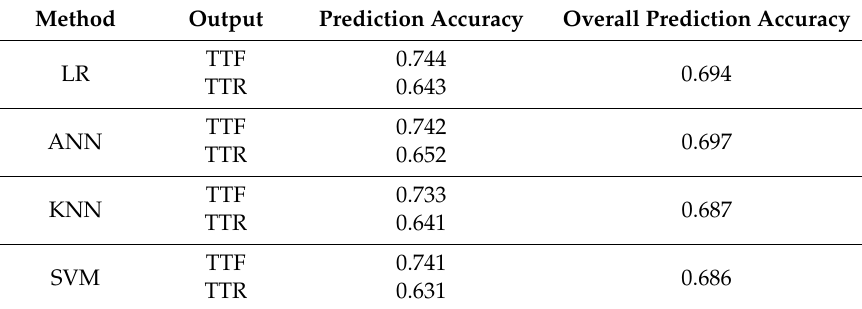
Table 6. Comparison of prediction